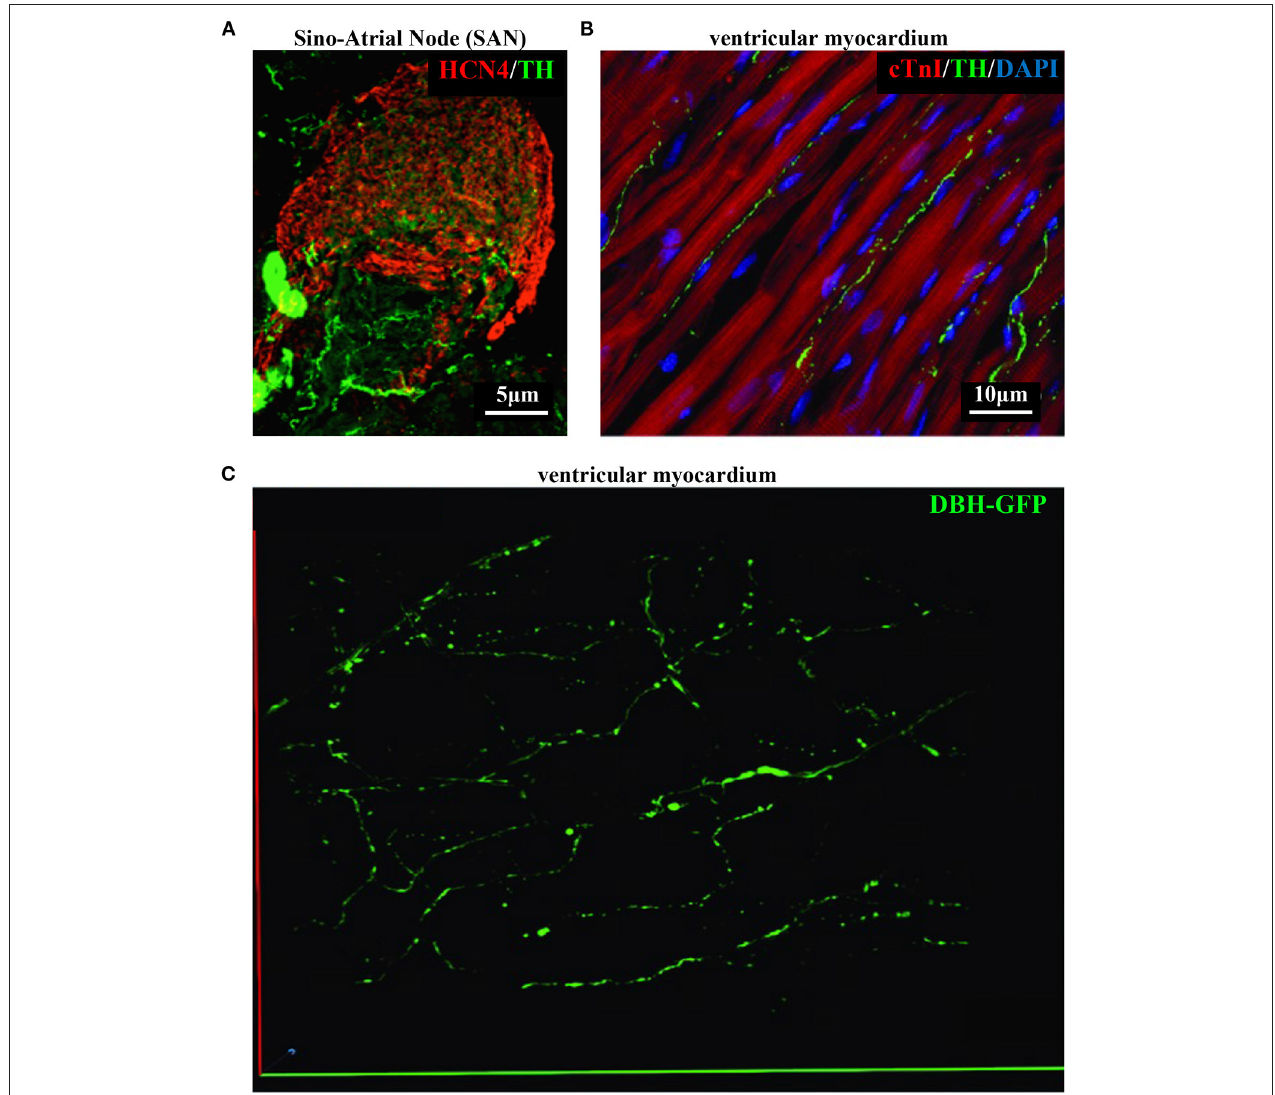
FIGURE 4 | Bi- and three-dimensional topology of cardiac sympathetic innervation. (A) Confocal immunofluorescence of the SAN of a normal adult mouse, co-stained with antibodies to tyrosine hydroxylase (TH) and HCN4, to identify SN processes and pacemaker cells, respectively. (B) Confocal immunofluorescence imaging of ventricular myocardial section from normal adult mice, stained with antibodies to TH and cardiac troponin I (cTnI). Nuclei are counterstained with DAPI. The image is a detail from the LV subepicardial region. (C) 3-D reconstruction, at the multi-photon microscope of the sympathetic network within a portion of the LV subepicardium in an adult, Langendorff-perfused DBH-GFP heart. A segment of 230 µ m by 28 µ m by 50 µ m was imaged. (A–C) Modified with permission from Prando et al. (2018) (A) , Zaglia and Mongillo (2017) (B) , and Freeman et al. (2014) (C)